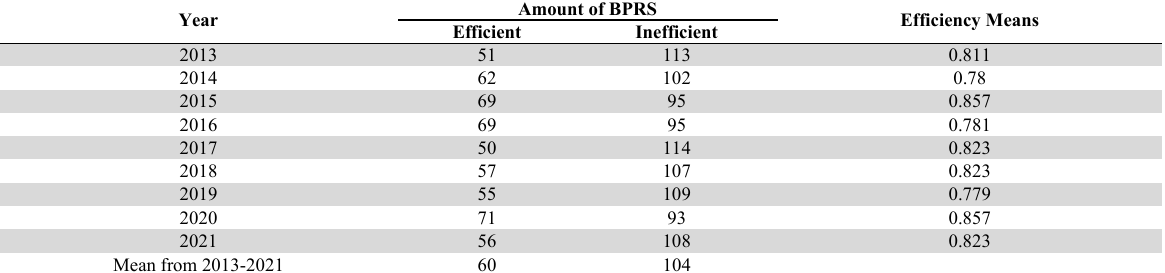
The efficiency of BPRS in Indonesia in the year 2013-2021